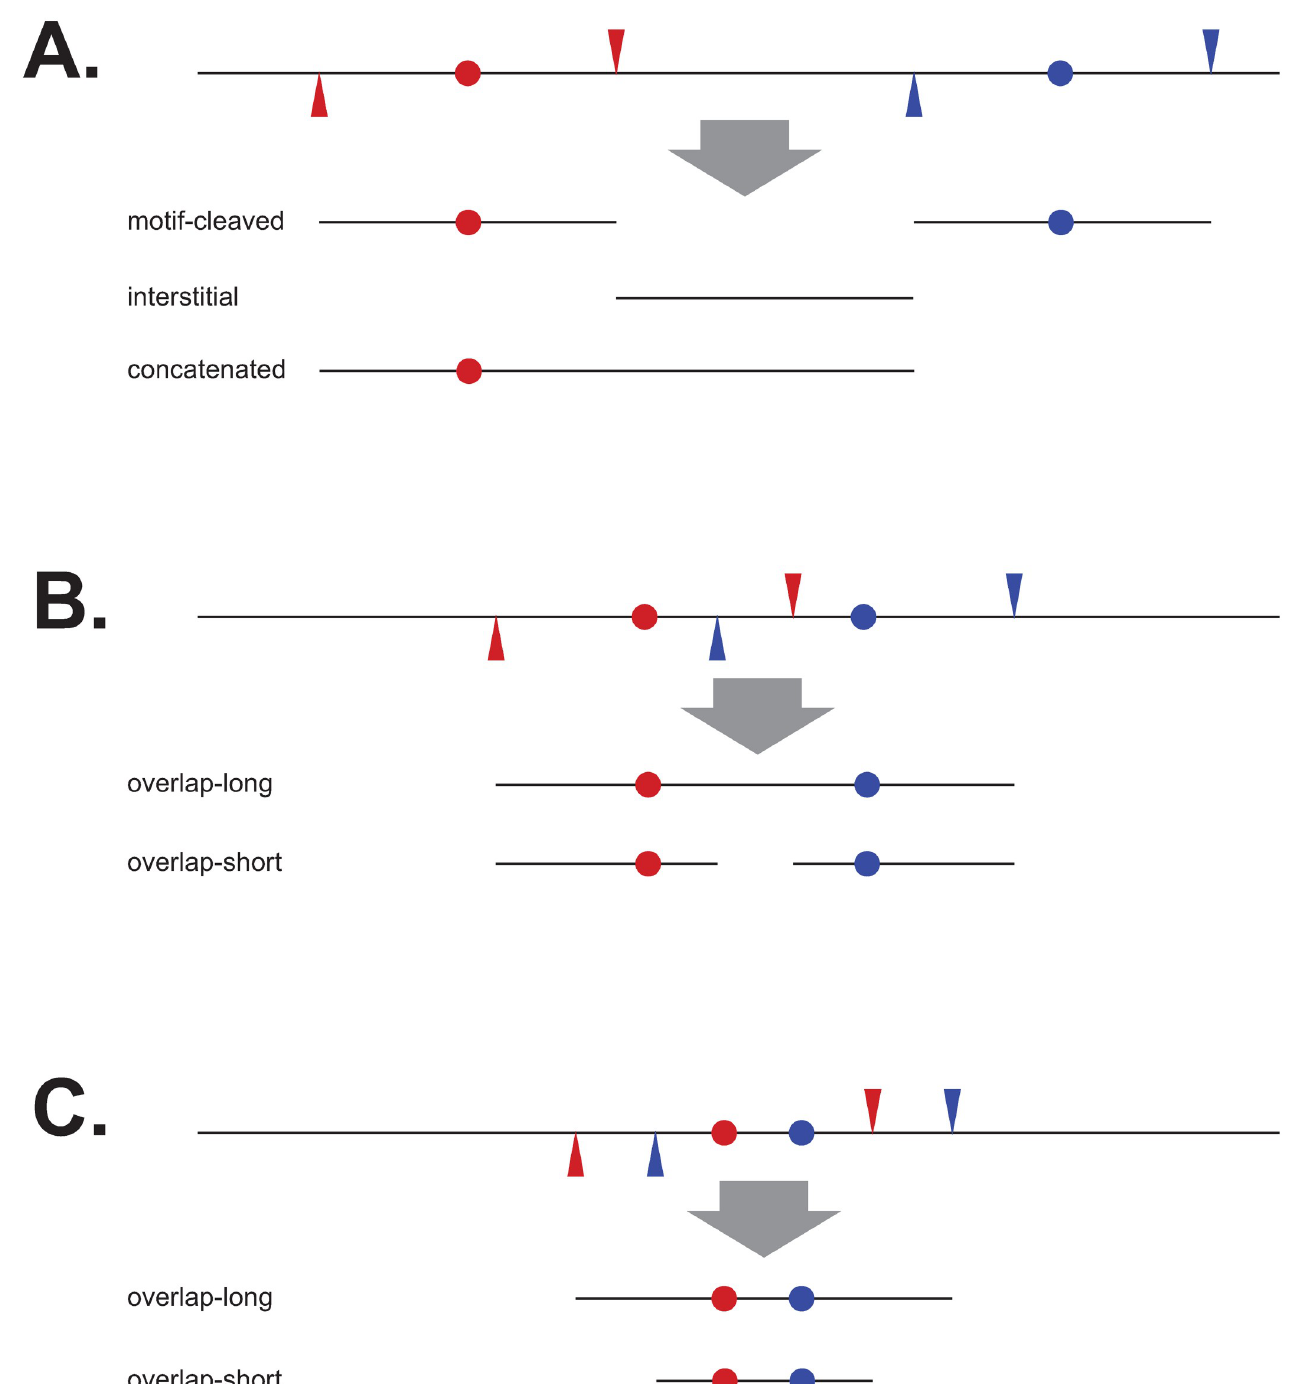
Fig 3. Example of theoretical fragment types generated by MFRE digestion. For simplicity, DNA is drawn as a single line, methylated motifs as colored dots, and cut sites on either side as triangles with color corresponding to that of the motif. Fragments were classified as one of six categories: “motif-cleaved” (when exactly cut, these are CCMD fragments), “interstitial” (regions between motif-cleaved fragments), “overlap-short” and “overlap-long” (created by cutting CCWGG sites less than 30 bp apart), “concatenated” (reads spanning an expected cut site, which most often consist of a motif-containing CCMD fragment joined to an interstitial fragment), and “other” (created by more complicated situations such as 3 or more clustered motifs). (A) Examples of motif-cleaved, interstitial, and concatenated fragments. (B) and (C) Examples of different types of overlap fragments, depending on whether any cleavage occurs between the two nearby